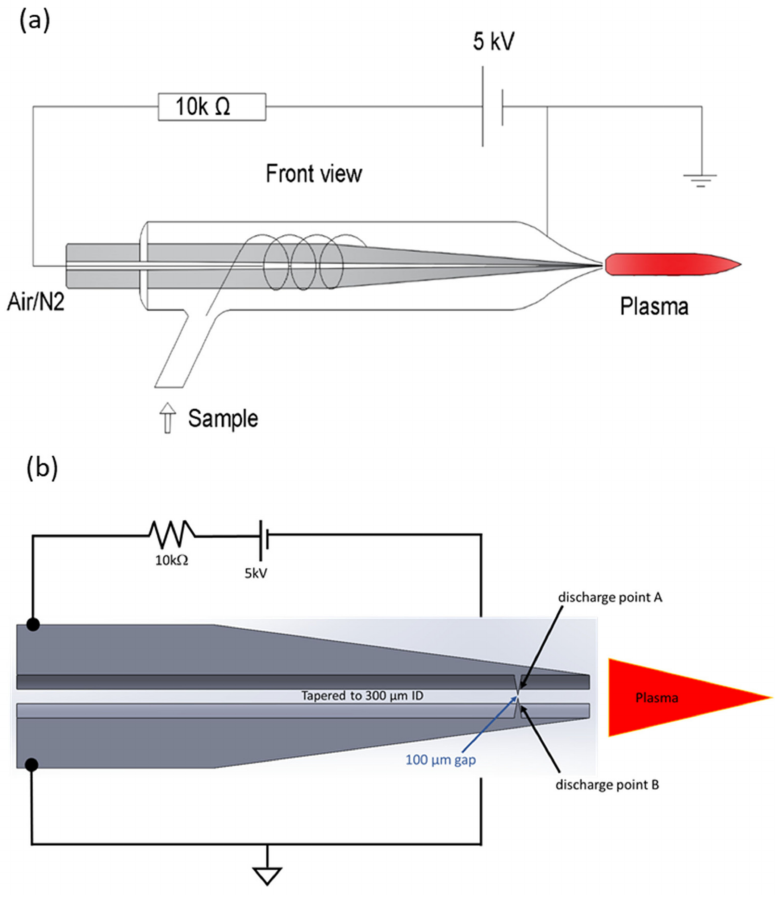
Figure 2. ( a ) Schematic diagram of possible cold plasma source incorporating a corona discharge needle (shown in 2b) as an insert with a side-arm for nebulized sample introduction as part of the design. The overall device would be <10 cm total length. ( b ) A schematic diagram of a corona discharge needle as the potential cold plasma source to be used either as an insert into a larger system or directly with very low sample flow rates. A discharge is generated between the two corona needles on each side of the tip. The discharge can then be used to generate a plasma from the concentric flow gas flow present surrounding the